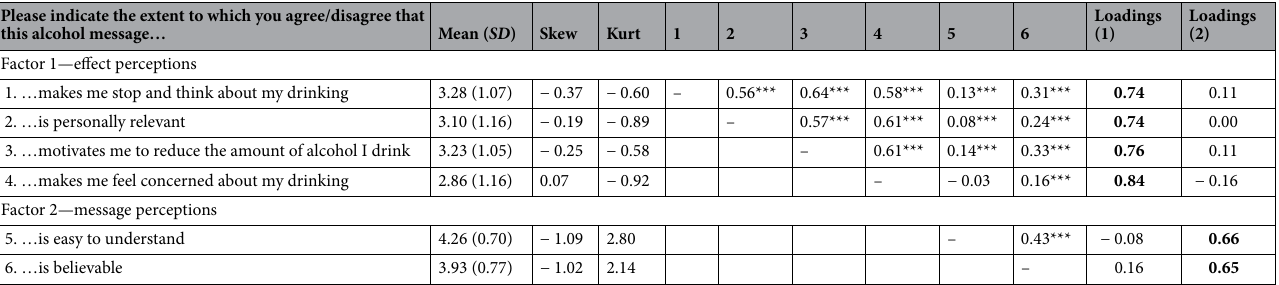
Table 1. Item-level descriptive statistics, inter-item correlations, and factor loadings ( n = 3001). Responses made on 5-point scales of 1 ( Strongly disagree ) to 5 ( Strongly agree ). Skew. = skewness; Kurt. = kurtosis. *** p < 0.001. Bold values denote factor loadings >